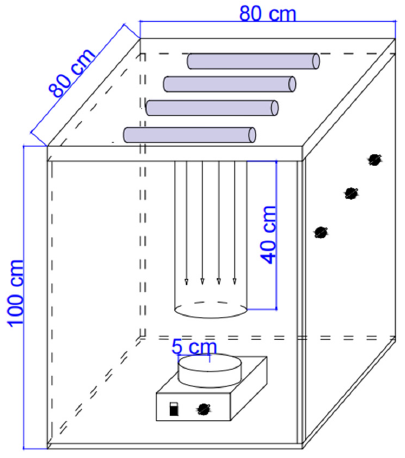
Figure 1. Schematic diagram of the ultraviolet collimated beam